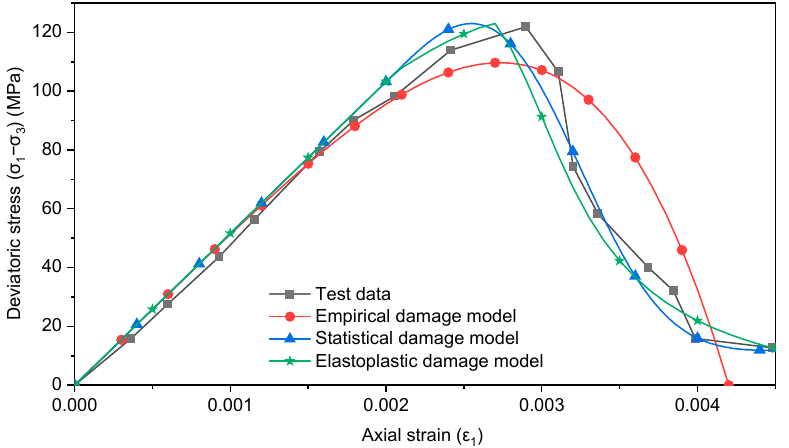
Figure 4. Stress–strain curves under uniform compression conditions.